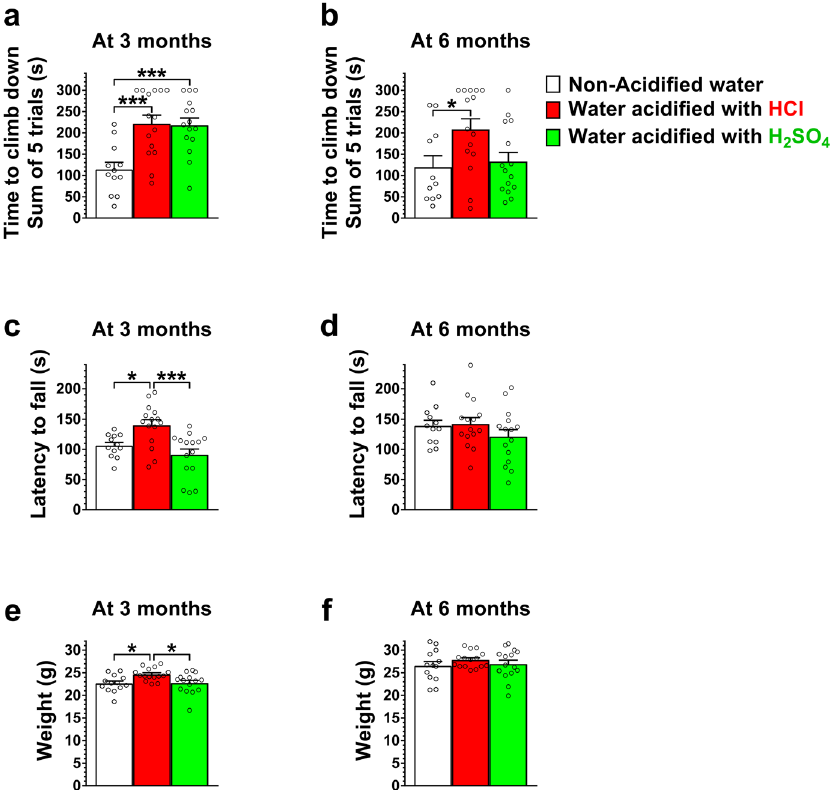
Figure 1. Drinking water acidified with H 2 SO 4 alters the motor behavior of 129S6/SvEv mice differently than water acidified with HCl. 129S6/SvEv male mice were either kept on non-acidified drinking water or received drinking water acidified with H 2 SO 4 or HCl from weaning (postnatal day 21). At the age of 3 and 6 months, mice were tested on a vertical pole to climb down and in an accelerating rotarod test (from 0 to 48 rpm in 240 s). ( a ) At 3 months of age, mice receiving H 2 SO 4 -acidified drinking water had difficulties to climb down a vertical pole, similarly to mice that received HCl-acidified drinking water. ( b ) At 6 months, the pole climbing ability of mice on H 2 SO 4 -acidified water and on non-acidified water was similar, whereas mice that received HCl-acidified water were still unable to climb down quickly. ( c )–( d ) H 2 SO 4 -acidified drinking water did not affect the rotarod test results at 3 and 6 months of age, whereas HCl-acidified drinking water enhanced the rotarod performance at 3 months. ( e )–( f ) Weight of the mice assessed in the behavioral tests at 3 ( e ) and 6 months ( f ) of age. Columns and bars represent mean ± SEM and the circles show the individual data (n = 12–15). Statistical significance was determined by 1-way ANOVA with Tukey’s post-test for multiple comparisons: * p < 0.05; *** p <